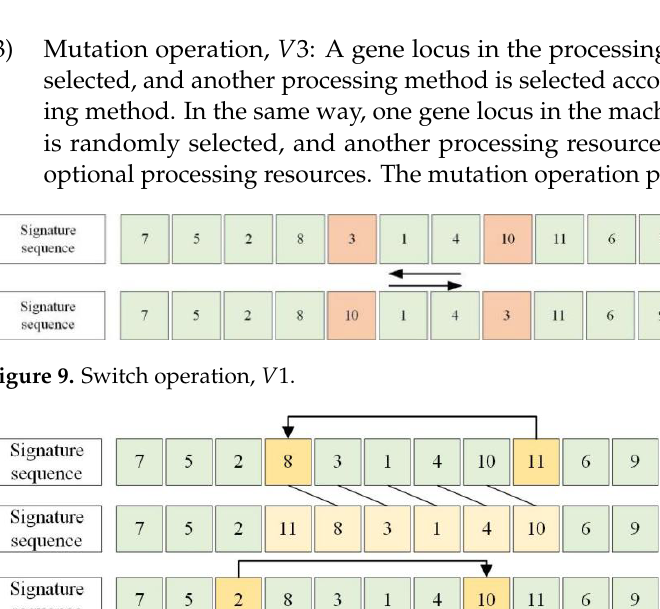
Figure 10. Insert Operation, 2 V .